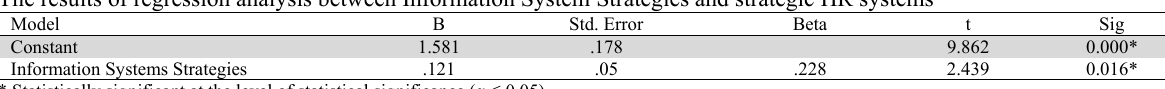
The results of regression analysis between Information System Strategies and strategic HR